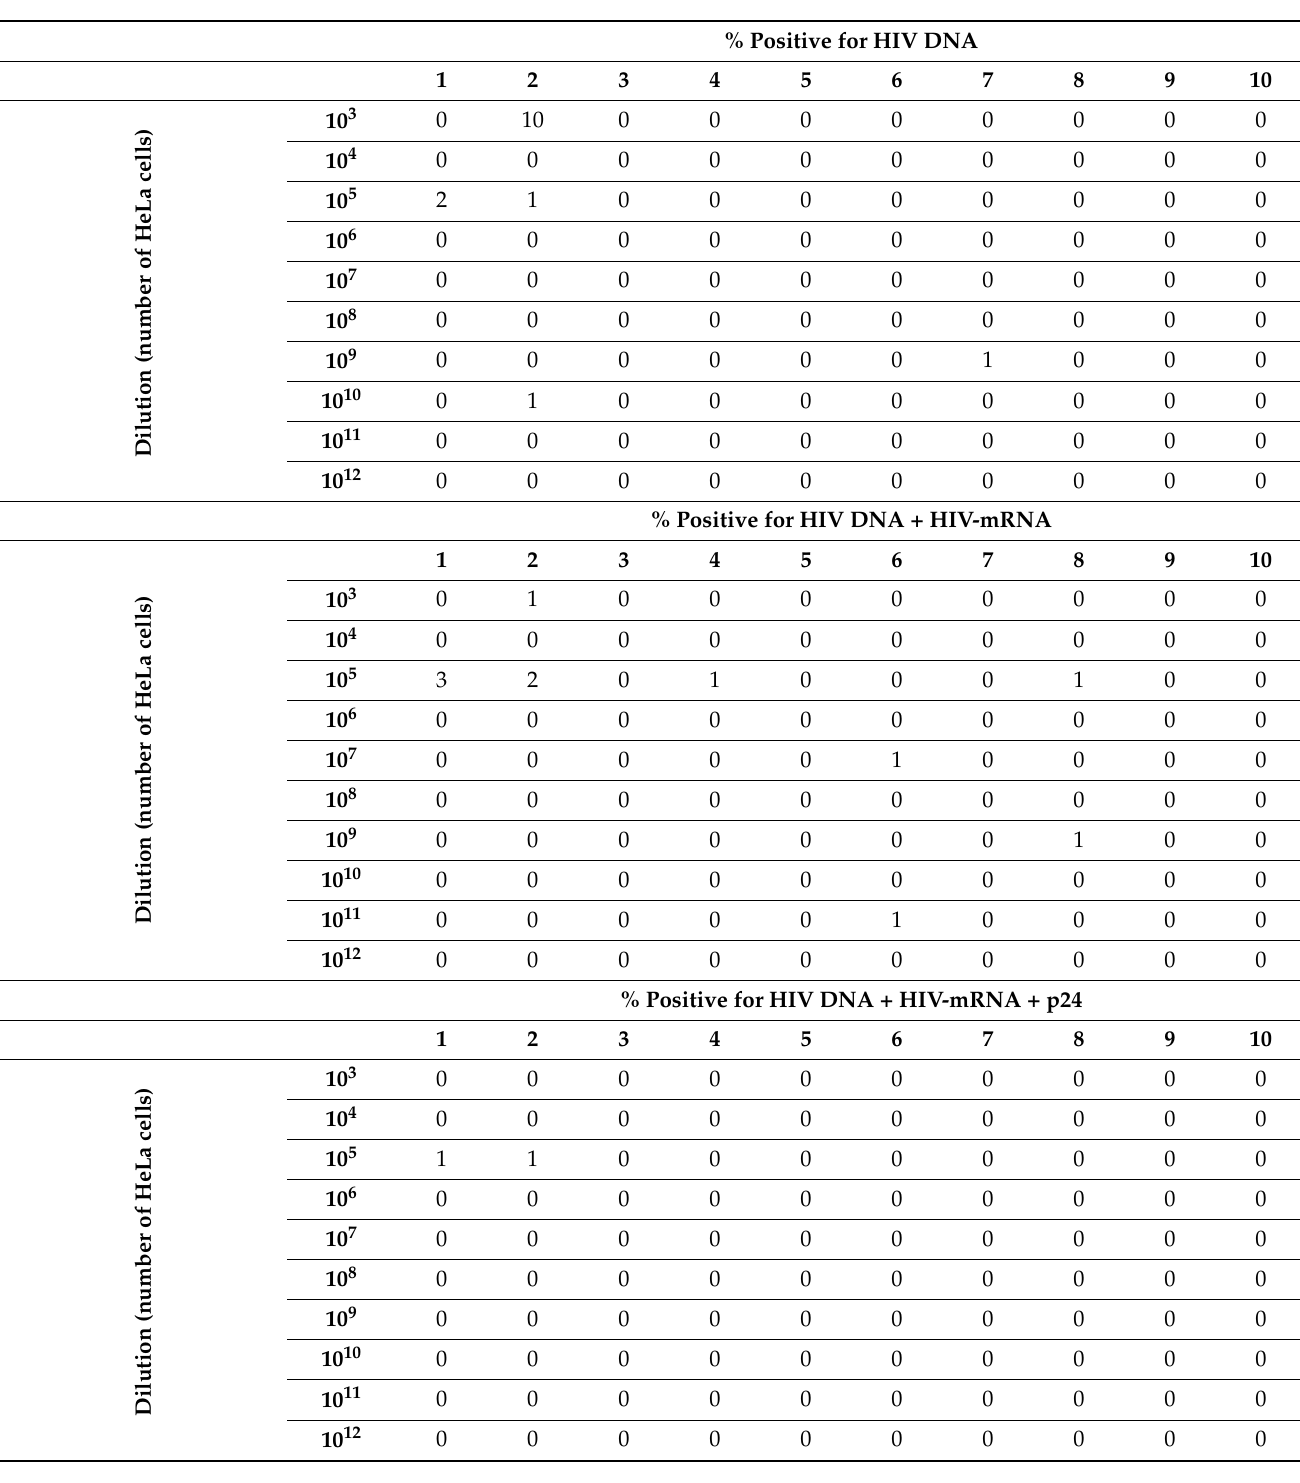
Table 3. Detection of HIV DNA, HIV-mRNA, and HIV protein in uninfected A3.01 cells. We diluted uninfected control cells (A3.01) to calculate our image system’s sensitivity to detect viral reservoirs. One to ten cells were diluted in 10 3 to 10 12 HeLa cells. Then, staining for HIV DNA (top), HIV-mRNA (middle), or HIV-p24 (bottom) was performed to identify whether we could detect the diluted cells in the HeLa cells. The percentage of detection is indicated for 10 sample preparations for each dilution. Pellets of these cells were cut and analyzed by microscopy to identify the infected